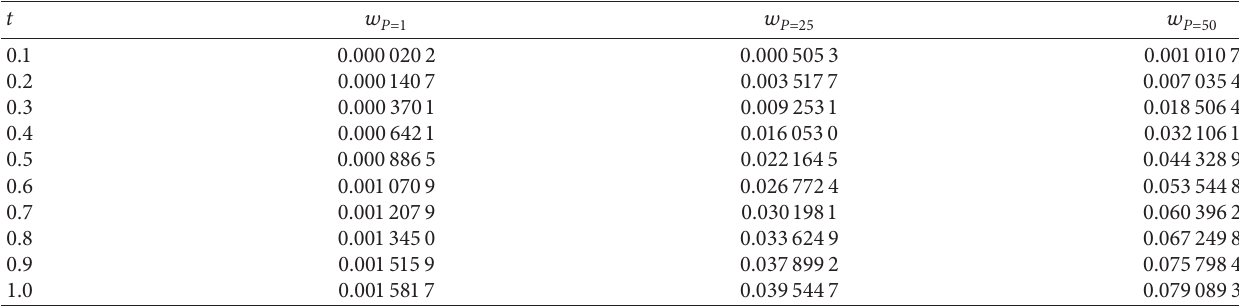
Table 2: Some values of w ( t, x ) for P � 1 , 25 , 50 (for a butyl B252 beam).